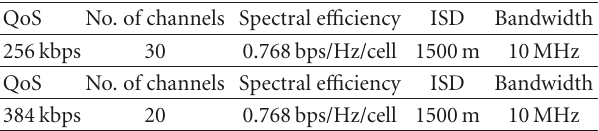
Table 2: Capacity values for 16QAM hierarchical multiresolution OFDMA.